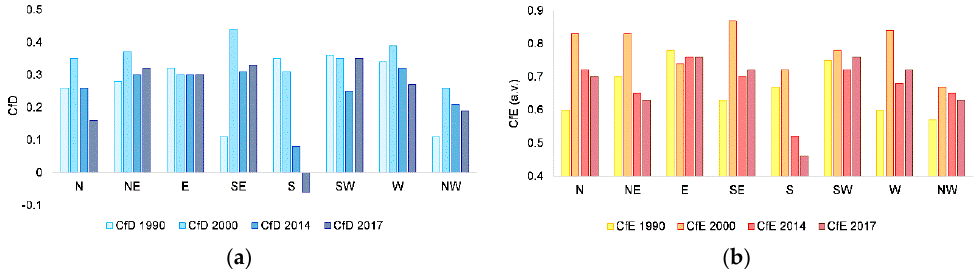
Figure 5. Median values of CfD ( a ) and CfE (a.v.) ( b ) indicators relative to the exposition of